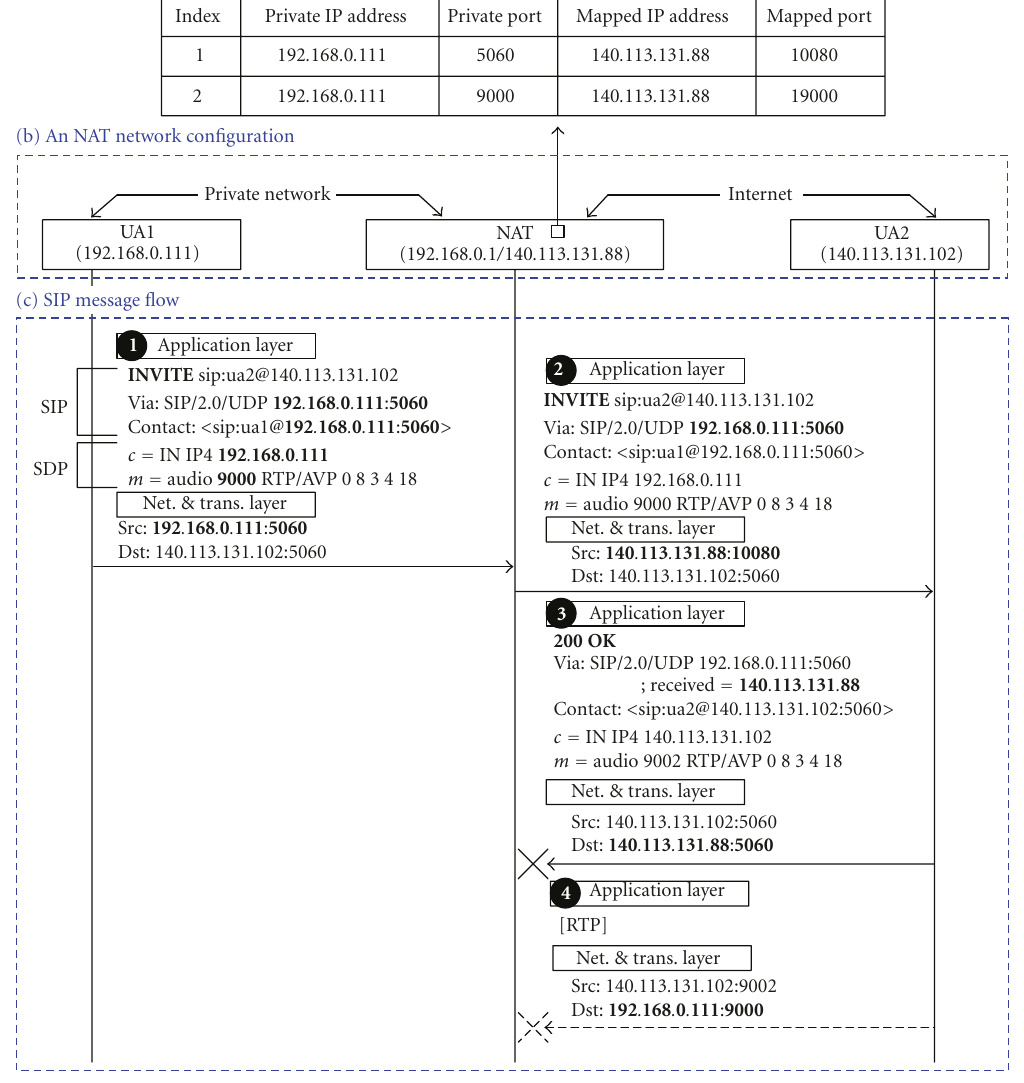
Figure 1: SIP message flow with standard NAT